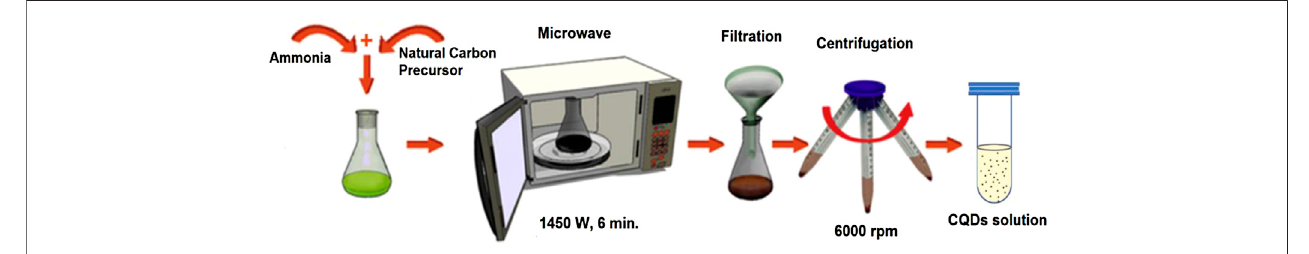
FIGURE 6 | Synthesis procedure for microwave-assisted pyrolysis for CQDs. This was adapted and modi fi ed with the permission from Monte-Filho et al. (2019).